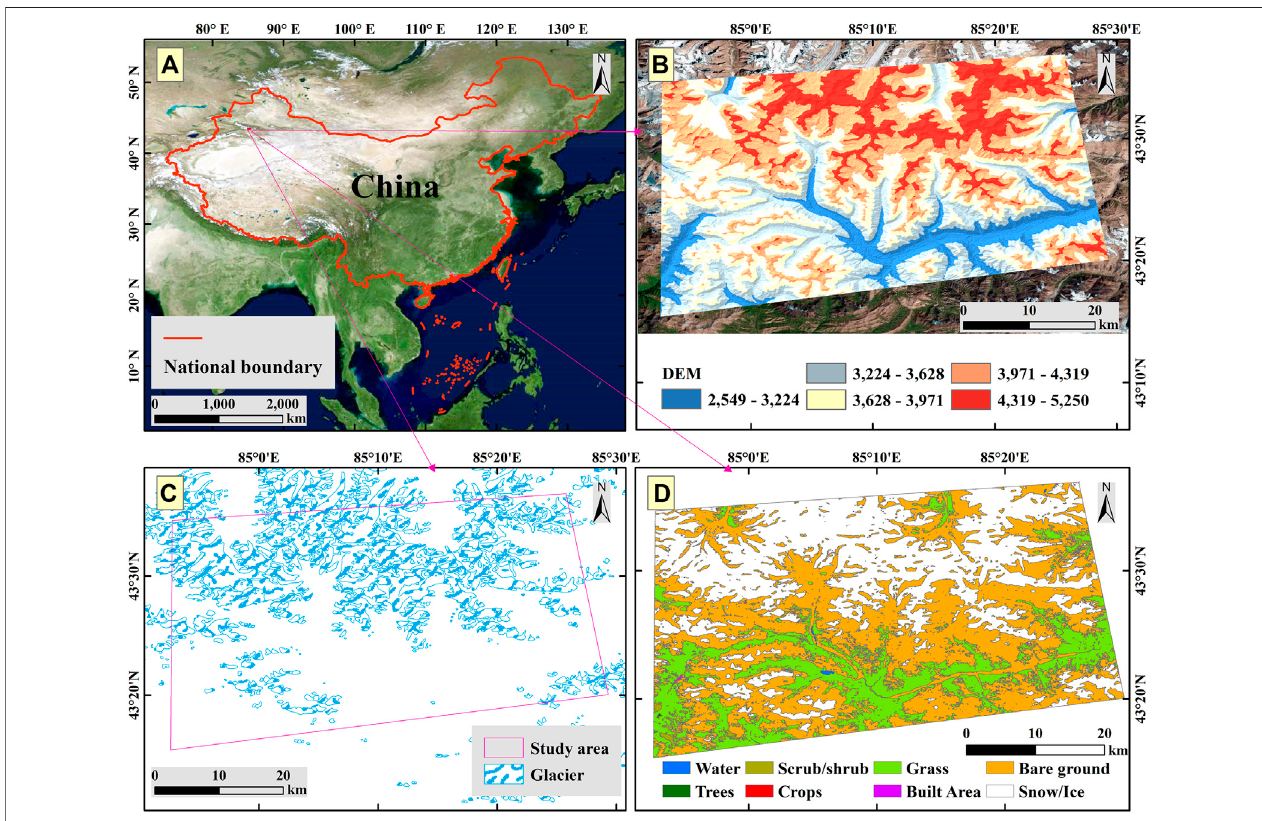
FIGURE1| Overviewmapofthestudyarea[ (A) locationofstudyareainChina; (B) digitalelevationmodel(DEM)ofthestudyarea; (C) distributionofglacierswithin the study area; (D) surface land cover of the study area derived from the Esri 2020 Global Land Cover dataset (Karra et al., 2021)].